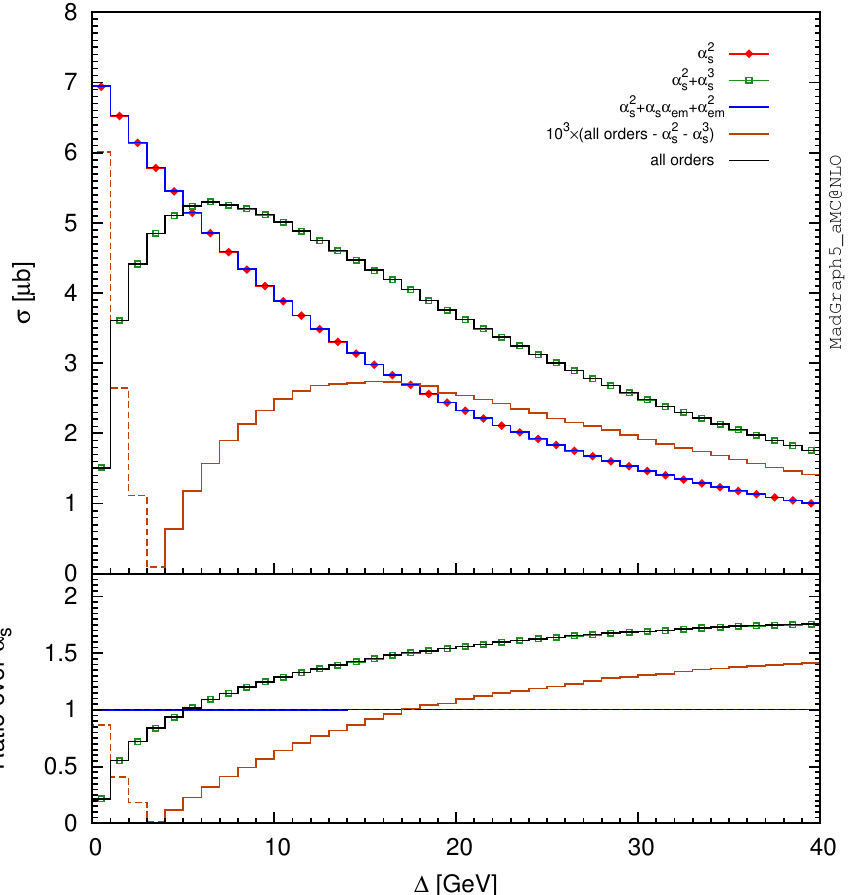
Figure 1 . Total dijet cross section as a function of (cid:1), according to the de(cid:12)nition given in eq.